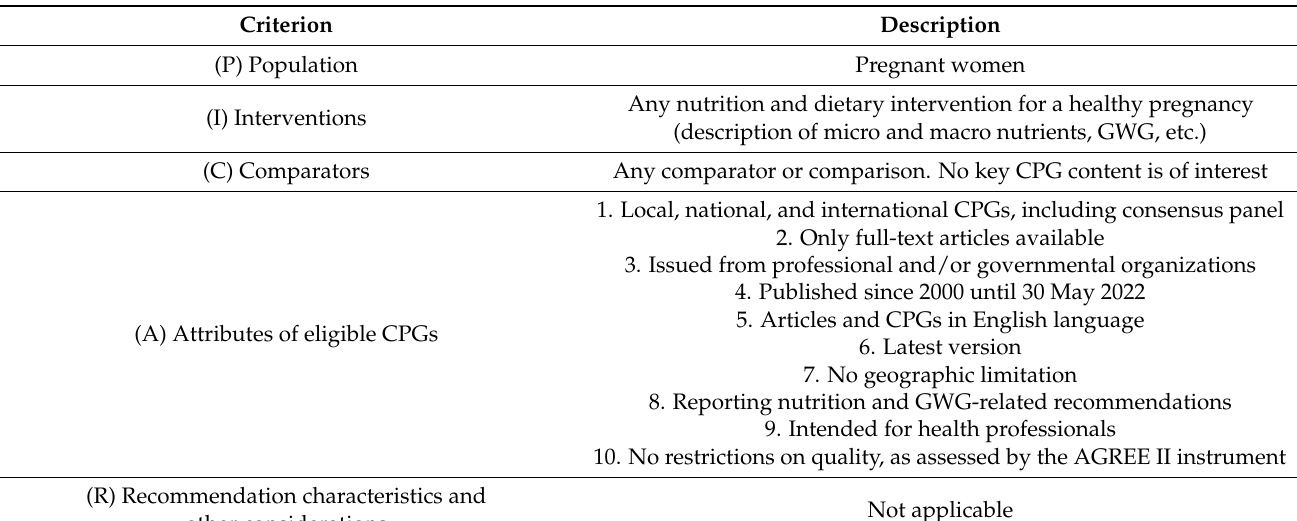
Table 1. PICAR statement for inclusion of